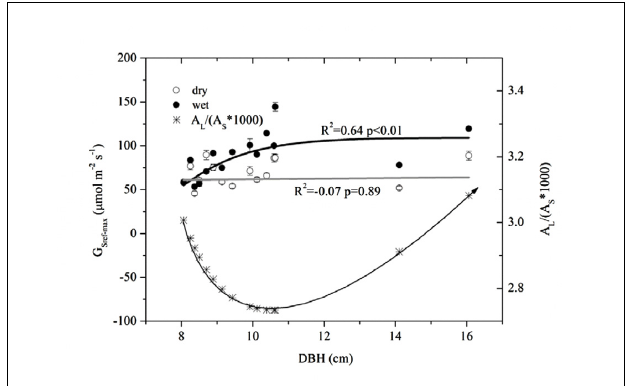
FIGURE 6 | Relationship between DBH and maximum stomatal conductance at reference D ( = 1 kPa) (G Sref - max ) derived from Figure 4, and, the A L /(A s ∗ 1000) based on the predicted A L and A s with DBH. Lines represent least square fits for dry (white circle) and wet (black circle) seasons respectively; data are mean ±